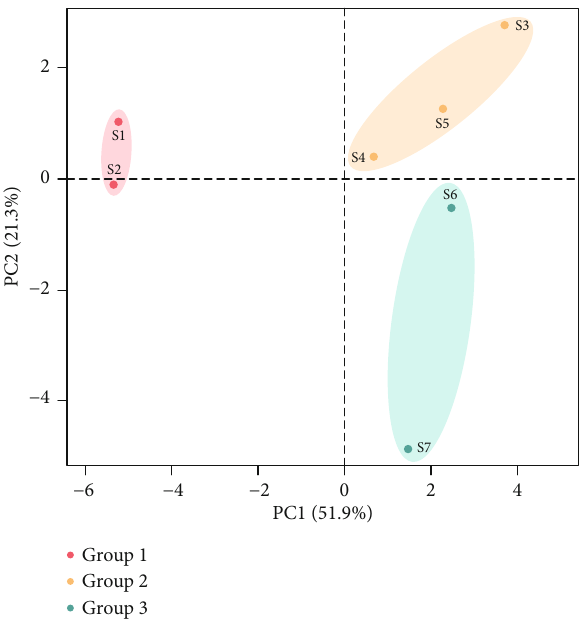
Figure 4: Principal component analysis (PCA) score plot of the identi fi ed polar metabolite compounds from seven ripening stages of the Agung Semeru plantains. Di ff erent coloured dots represent clustered stages in a group. Each stage is represented by averages of triplicates. S1: stage 1; S2: stage 2; S3: stage 3; S4: stage 4;